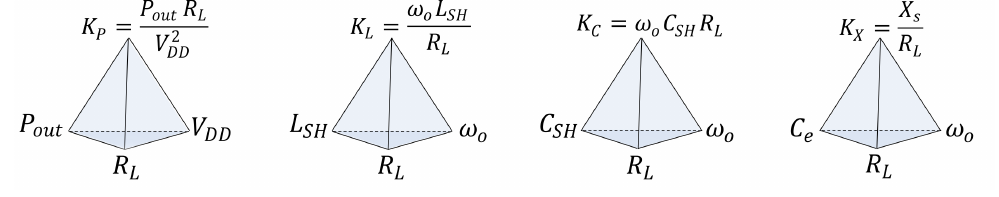
Figure 4. Design set relations